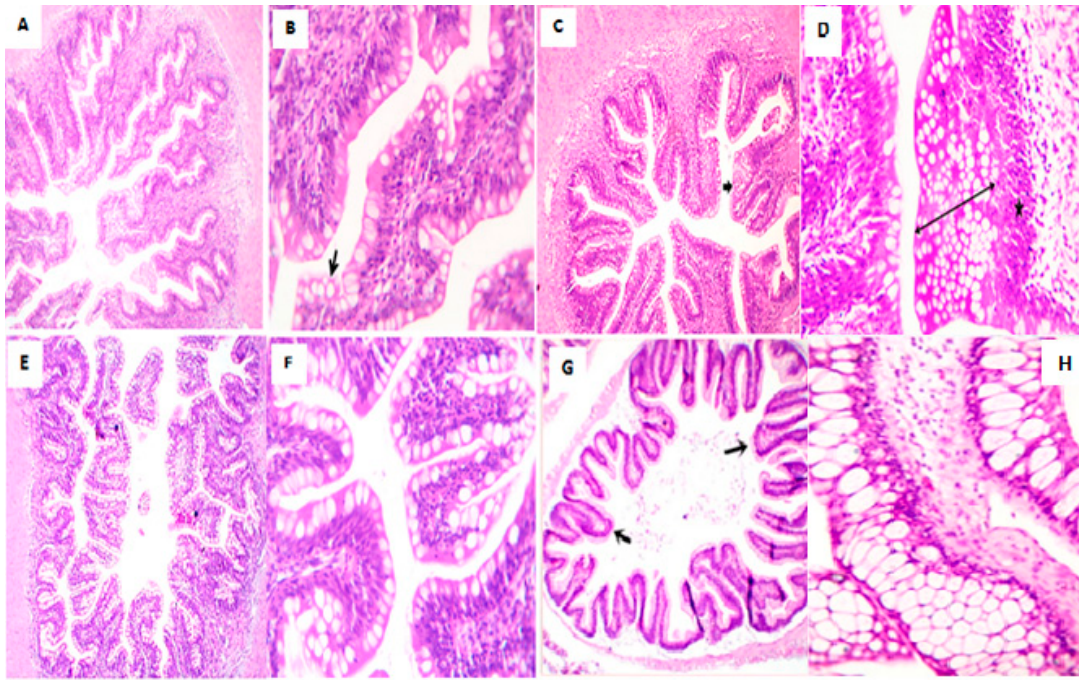
Figure 2. Photomicrograph of the posterior part of the fish intestine ( A ) showed tall and serrated villi surfaces with mildly thickened lamina propria. Hematoxylin and eosin (H&E) ×100 ( B ) showed moderate goblet cell metaplasia (arrow) in serrated villi surface with mild intraepithelial and lamina propria lymphocytic infiltration. H&E ×400 ( C ) showed thickly branched villi with marked goblet cells metaplasia (arrow). H&E ×100 ( D ) showed large goblet cells at several rows (two-sided arrow) followed by proliferated enterocytes (star). H&E ×400 ( E ) showed marked short thick villi with goblet cells metaplasia. H&E ×100 ( F ) showed intense goblet cells metaplasia and lymphocytic infiltrations. H&E ×400 ( G) ,( H ) showed tall villi with numerous broad tips (arrows) and goblet cell metaplasia at low 40× and high magnification 400×. (DPFP0 = A,B; DPFP5 = C,D; DPFP10 = E,F; DPFP15 = G,H).